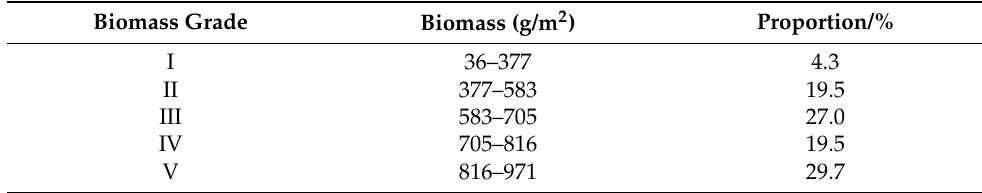
Table 4. Biomass classification of Ulva pertusa in the sample area based on GBDT model